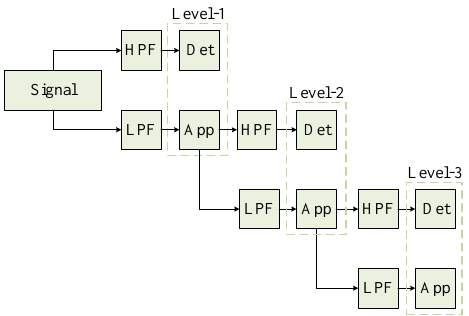
Figure 5. Wavelet decomposition tree at Level 3. Det, detail; App, approximation.